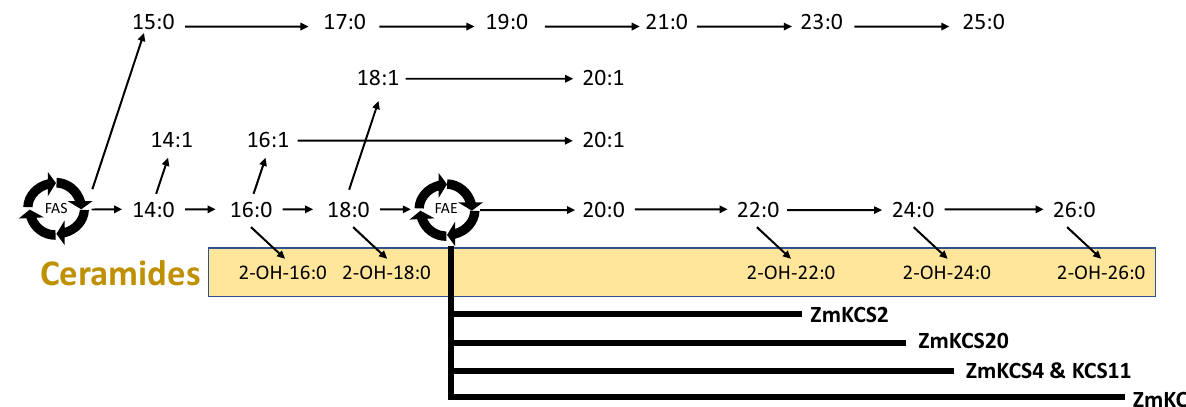
Figure 6. Enzymatic capabilities of the Zm KCS isozymes in generating VLCFAs. Metabolic model of the enzymatic capabilities of Zm KCS isozymes based on the VLCFA profiles expressed by the scelo2; scelo3 double mutant strains, complemented by the expression of different Zm KCS isozymes. FAS generated fatty acyl-CoAs of up to 18-carbon chain-length can be desaturated to generate monounsaturated fatty acids. FAE elongates these saturated and monounsaturated fatty acids to lengths of up to 26-carbons, and these fatty acids can be hydroxylated at the 2-position after they are incorporated into ceramide lipids. Bold lines at the bottom of the figure identify the differential enzymatic capability of each Zm KCS isozyme to catalyze elongation of fatty acids to specific chain